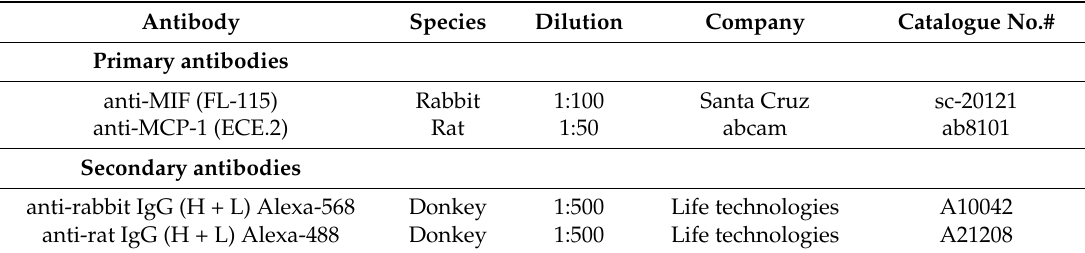
Table 1. Antibodies for immunofluorescence